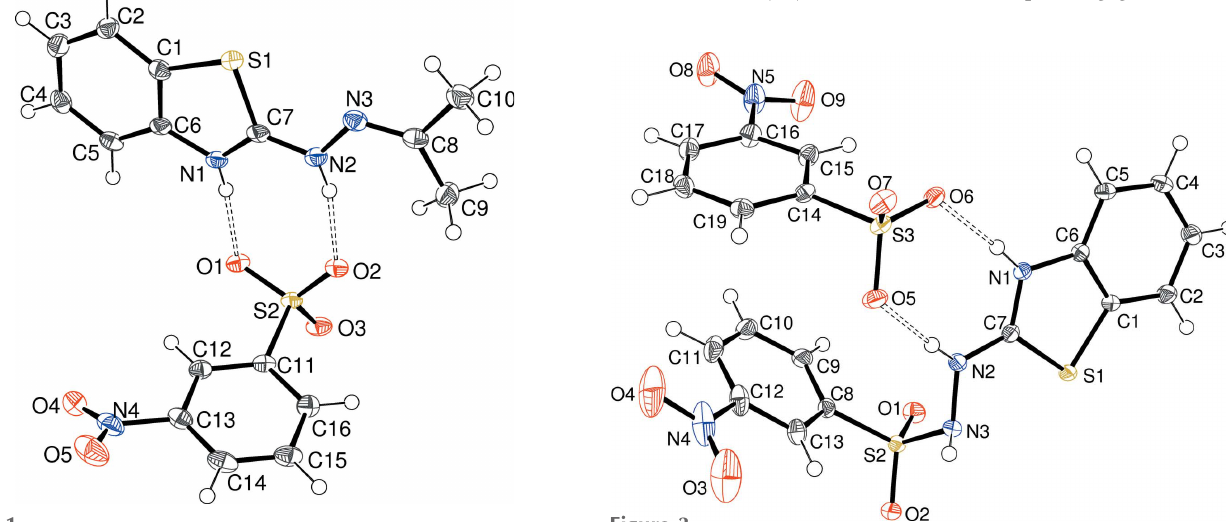
Figure 3 The asymmetric unit of (III) showing 50% displacement ellipsoids. Hydrogen bonds are indicated by double-dashed